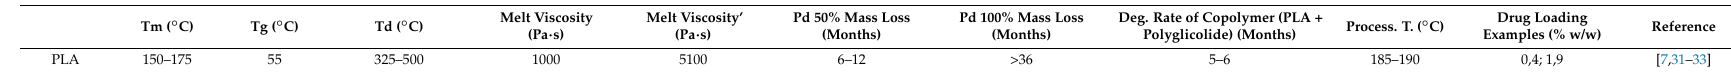
Table 4. Poly(lactic acid) properties. Key: Tm (melting temperature); Tg (glass transition temperature); Td (degradation temperature); Melt viscosity (at 200 ◦ C); Melt viscosity’ (at >200 ◦ C); Pd (degradation period until 50% or 100% mass loss occur); Deg. Rate (degradation rate of copolymer); Process. T. (processing temperature for the polymer).